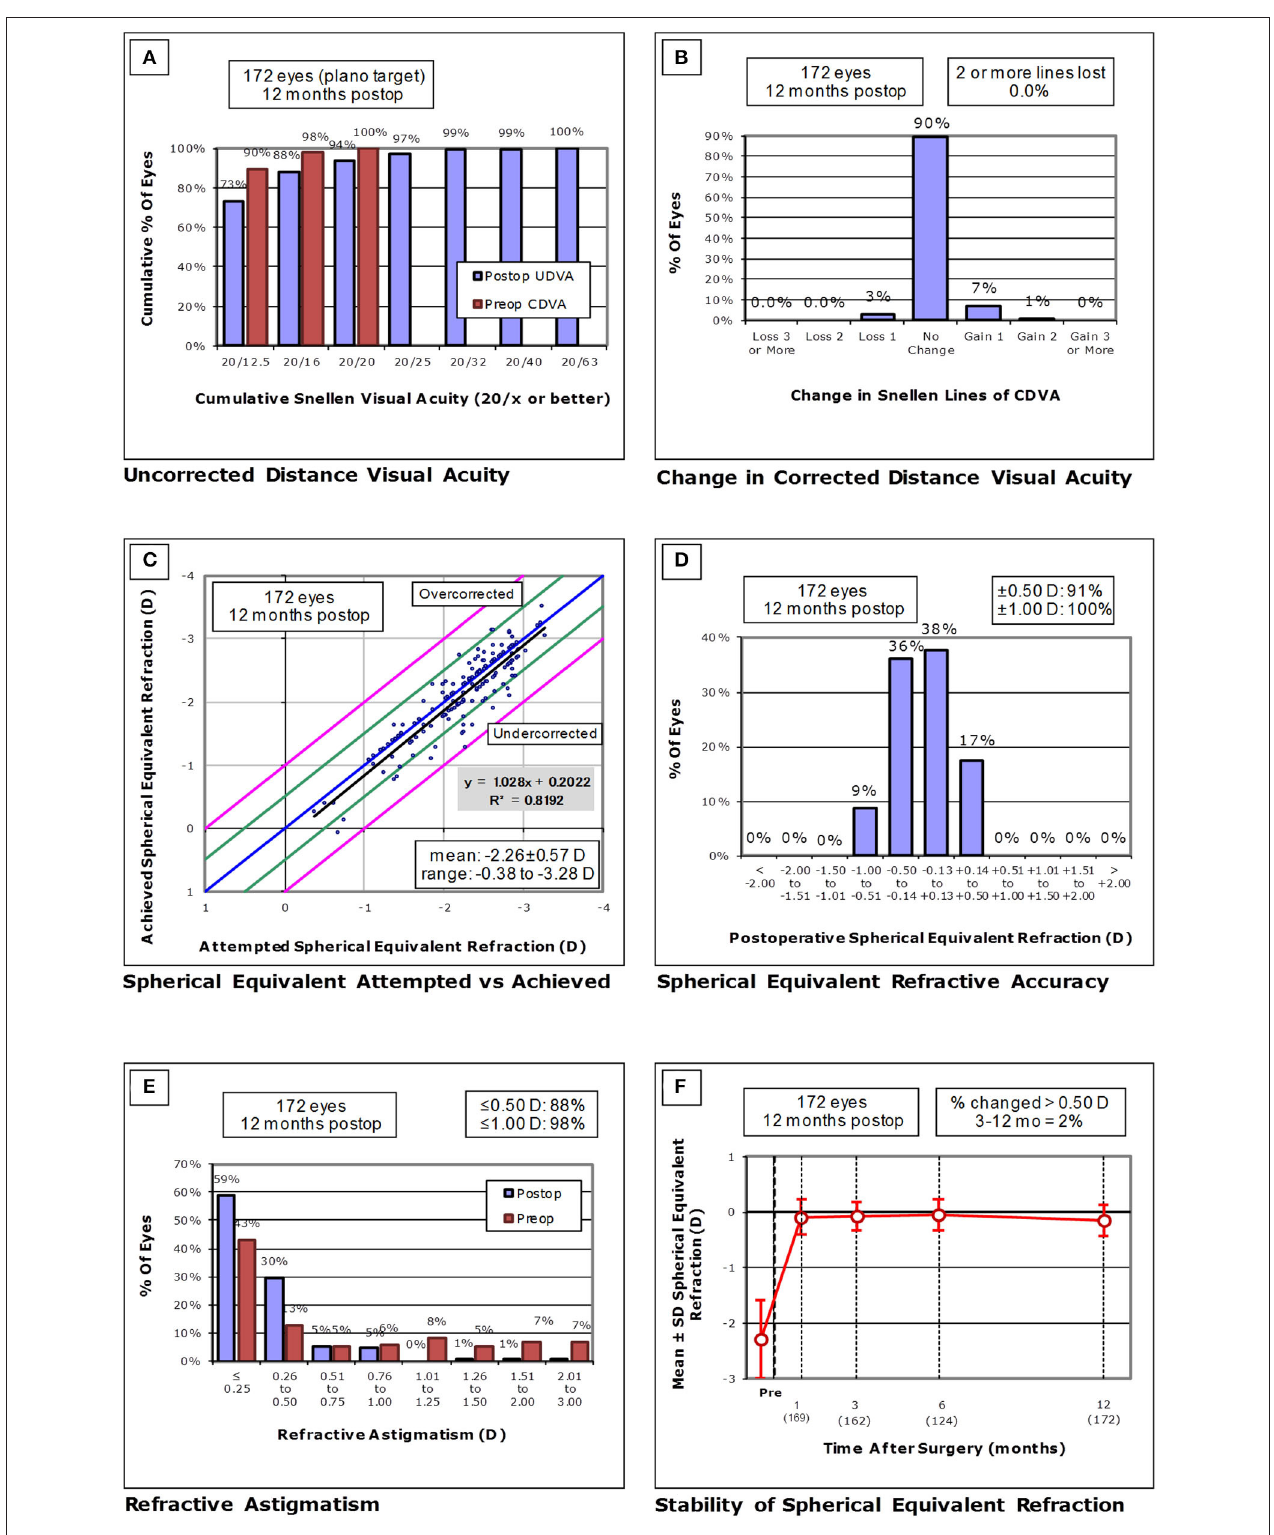
FIGURE 1 | (A) Cumulative percentages of eyes attaining specified cumulative levels of uncorrected distance visual acuity (UDVA), (B) Changes in corrected distance visual acuity (CDVA), (C) A scatter plot of the attempted vs. the achieved manifest spherical equivalent (MSE) correction, (D) Distribution of spherical equivalent refractive accuracy, (E) Distribution of refractive astigmatism, and (F) Time course of changes in MSE.